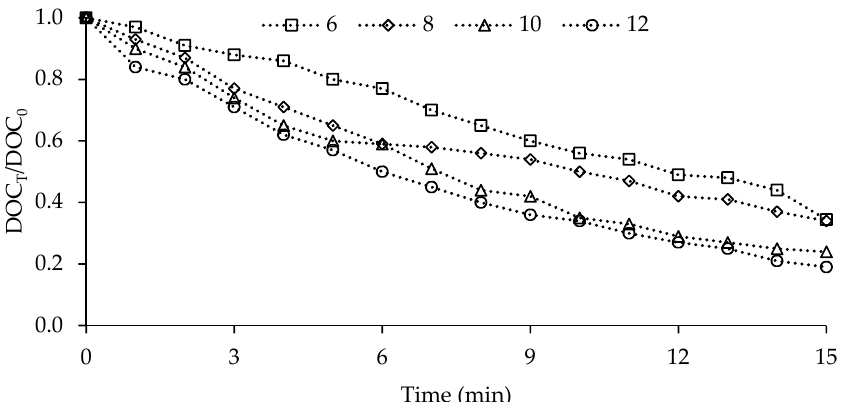
Figure 8. Effect of ozone dosage on the performance of catalytic ozonation (The ozone dosages are given in mg L − 1 Conditions: t = 22 °C, pH = 6.72, [HA] = 10 mg L − 1 , [Catalyst] = 0.050 g L − 1 ).